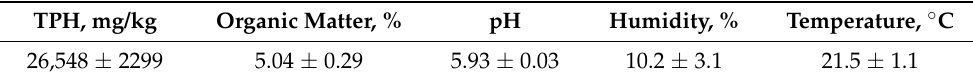
Table 3. The initial content of TPH and organic matter, humidity, pH and temperature of soil in the contaminated